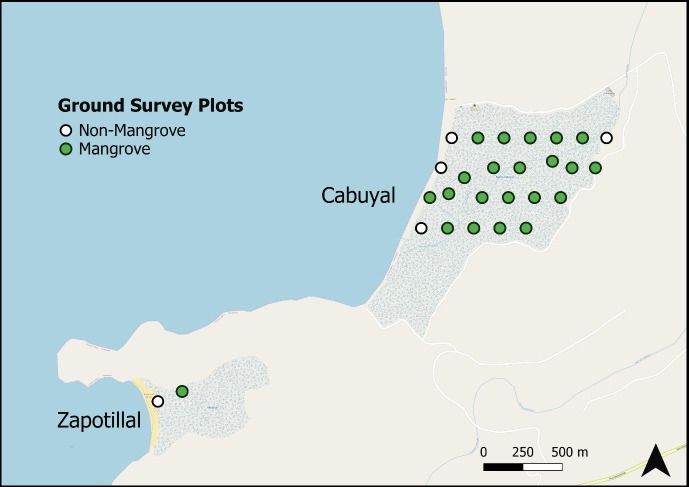
Map of ground survey plot locations within the Cabuyal and Zapotillal estuaries.Plots classified as containing or not containing mangroves or associate species. Map data copyrighted OpenStreetMap contributors and reprinted under a CC BY-SA 2.0 license and available from https://www.openstreetmap.org.